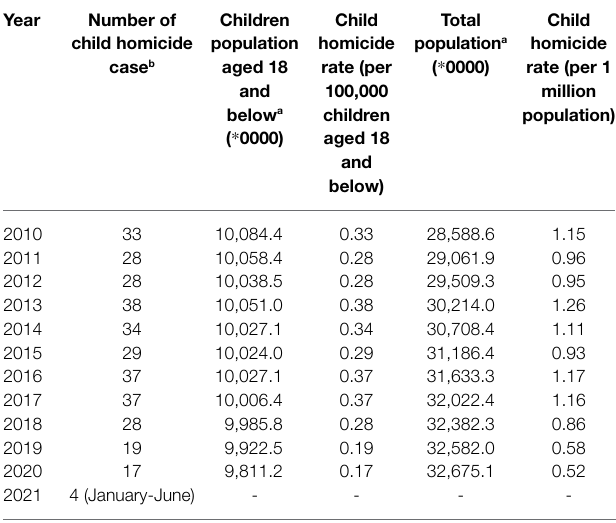
TABLE 1 | Number and estimated rates of child homicide for Malaysia from January 2010 to June 2021.